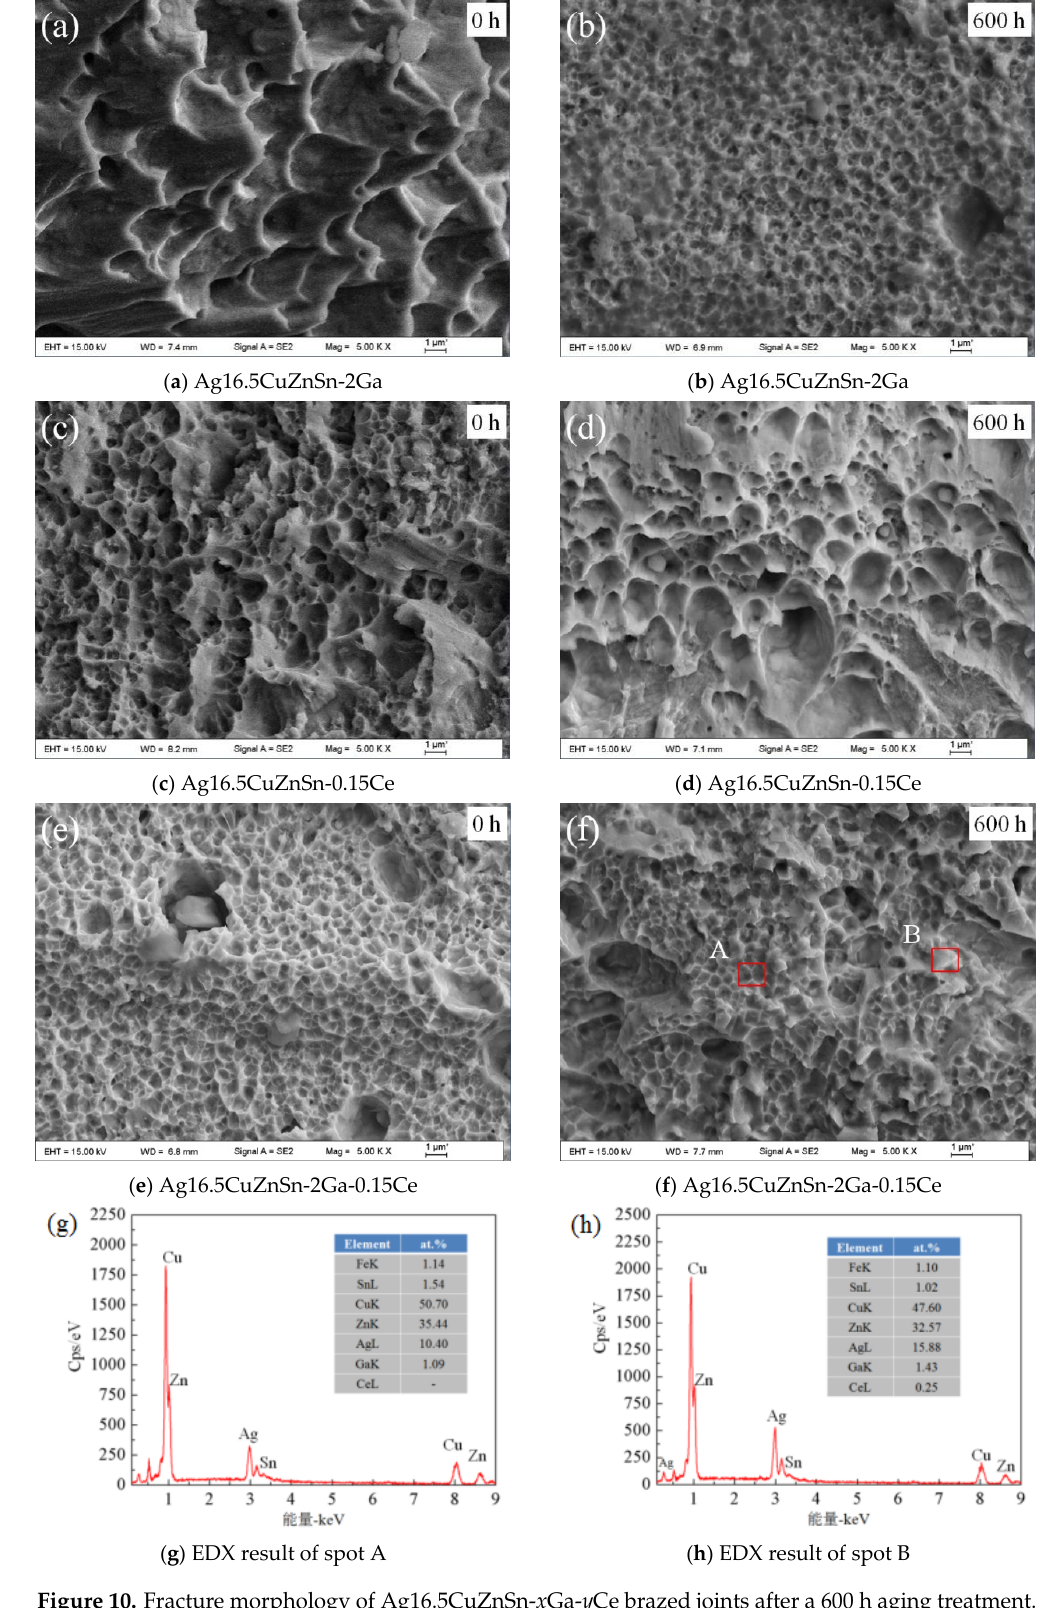
Figure 10. Fracture morphology of Ag16.5CuZnSn- x Ga- y Ce brazed joints after a 600 h aging treatment.